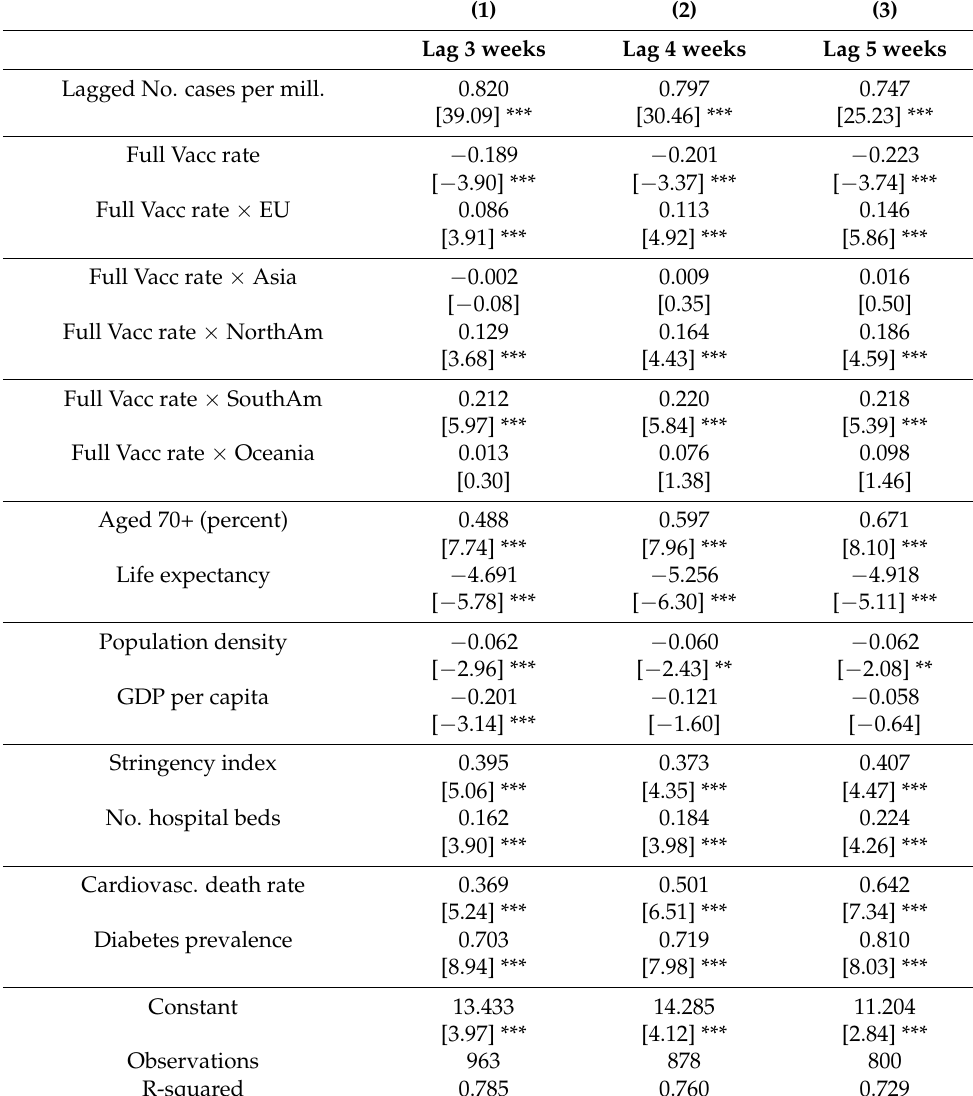
Table A6. Impact of vaccination rate on number of new COVID